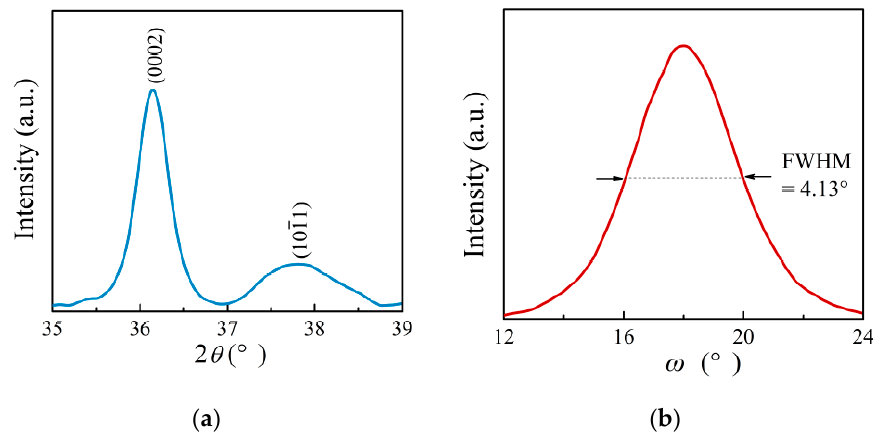
Figure 5. ( a ) High-resolution XRD pattern and ( b ) X-ray rocking curve of the Sc 0.29 Al 0.71 N thin film. Next, the ferroelectric hysteresis and field-induced strain curve of the Sc 0.29 Al 0.71 N thin film was investigated with a ferroelectric analyzer (Aixacct TF-2000). Figure 6 shows the measured field induced strain of the Sc 0.29 Al 0.71 N thin film as a function of an applied electric field. The experimental data showed that the induced strain varied linearly with both an increasing and decreasing electric field. An effective piezoelectric coefficient d 33 of 12.6 pC/N could be estimated by linear fitting, which was slightly small compared to that of Akiyama’s work (~13.7 pC/N) [30]. This may have been caused by the difference in thin